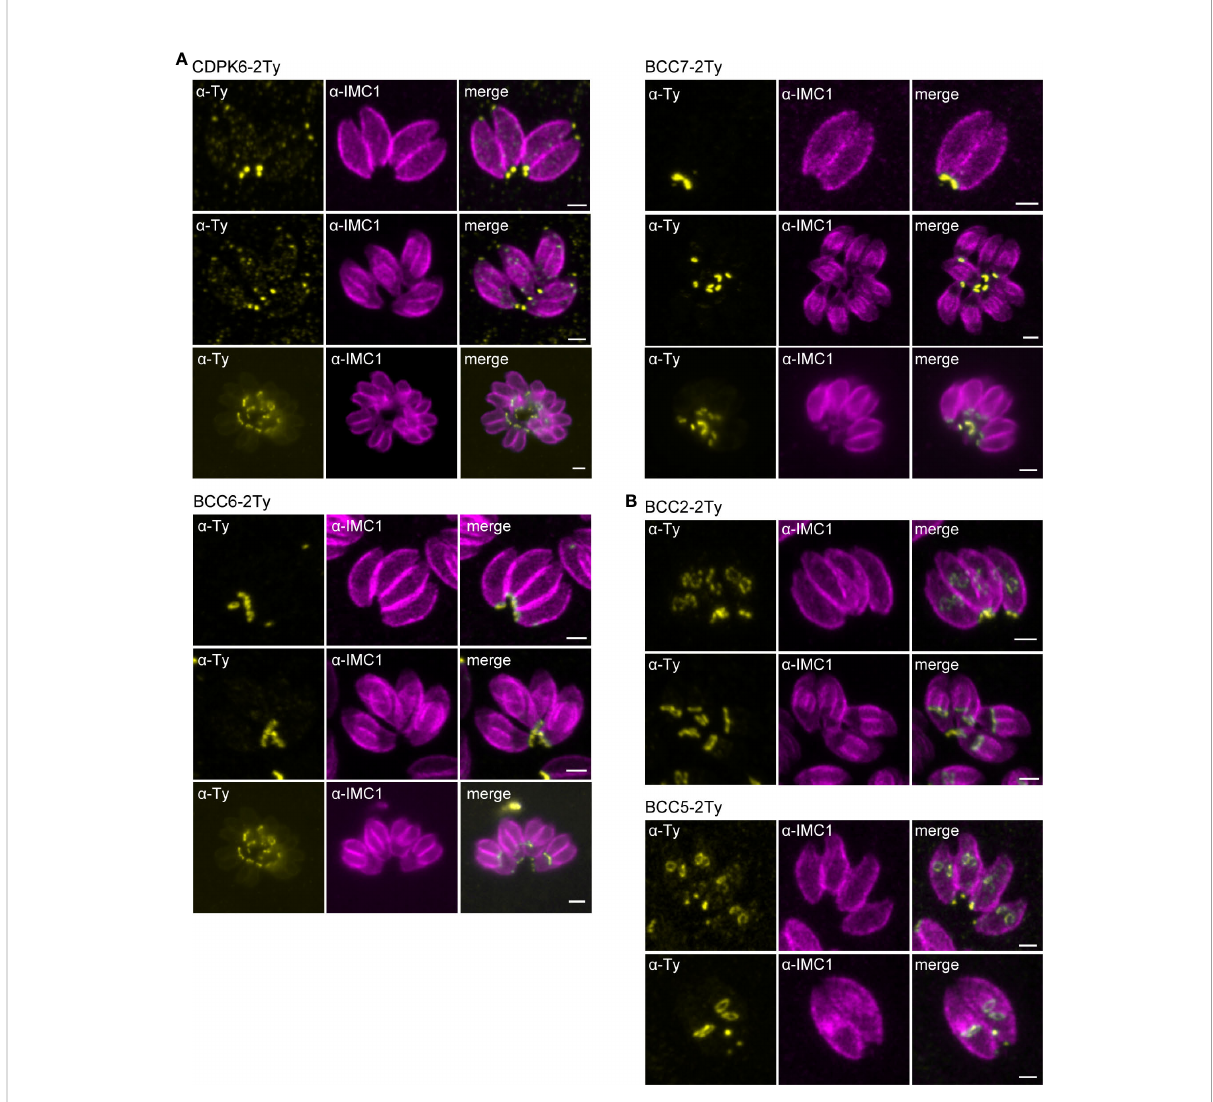
FIGURE 2 BCCs targeted to the basal complex very late or very early during cell division. (A) Endogenous tagging of CDPK6, BCC6, and BCC7 shows that these proteins appear at the basal complex in mature parasites only. Note that CDPK6 is also found at the apical pole of the parasites including in the daughter cells. (B) In contrast, BCC2 and BCC5 are observed very early during division, appearing as a ring before the IMC1 staining of the daughter cells. Magenta: rabbit anti-IMC1, Yellow: mouse anti-Ty. Scale bars: 2 m